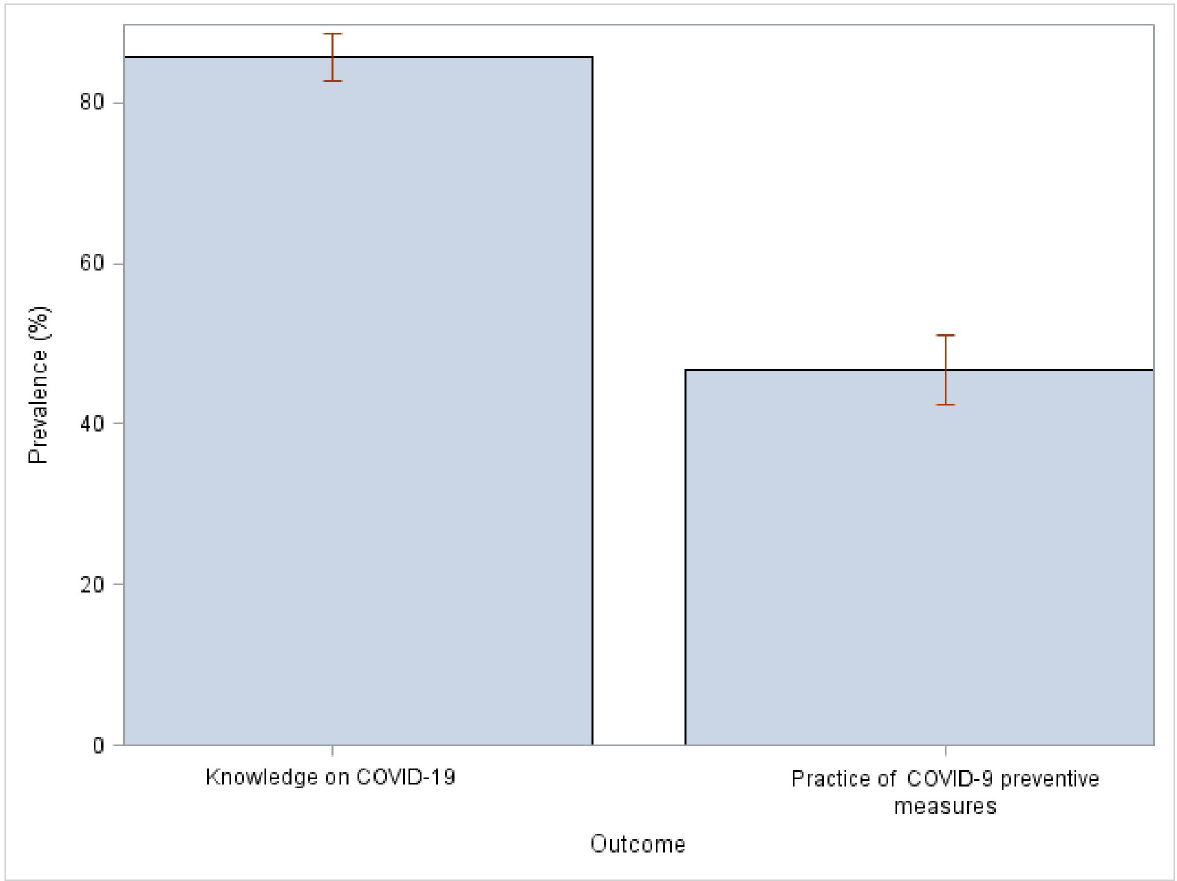
Fig 1. Prevalence of knowledge and COVID-19 preventive